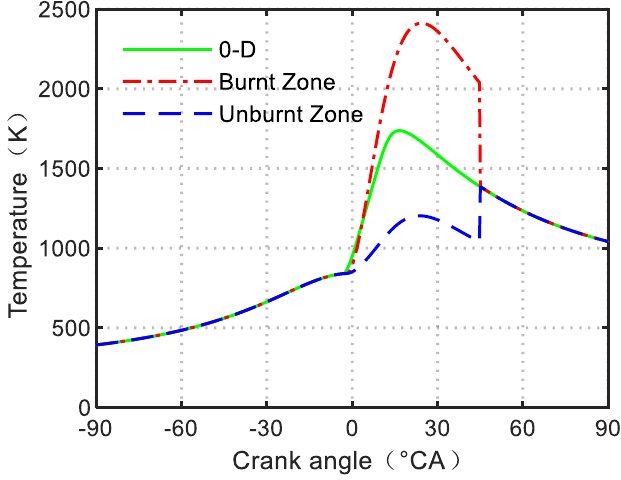
Figure 11. Gas temperature in